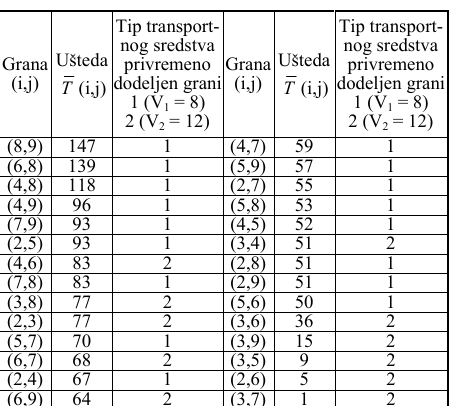
U{tede i tipovi transportnih sredstava